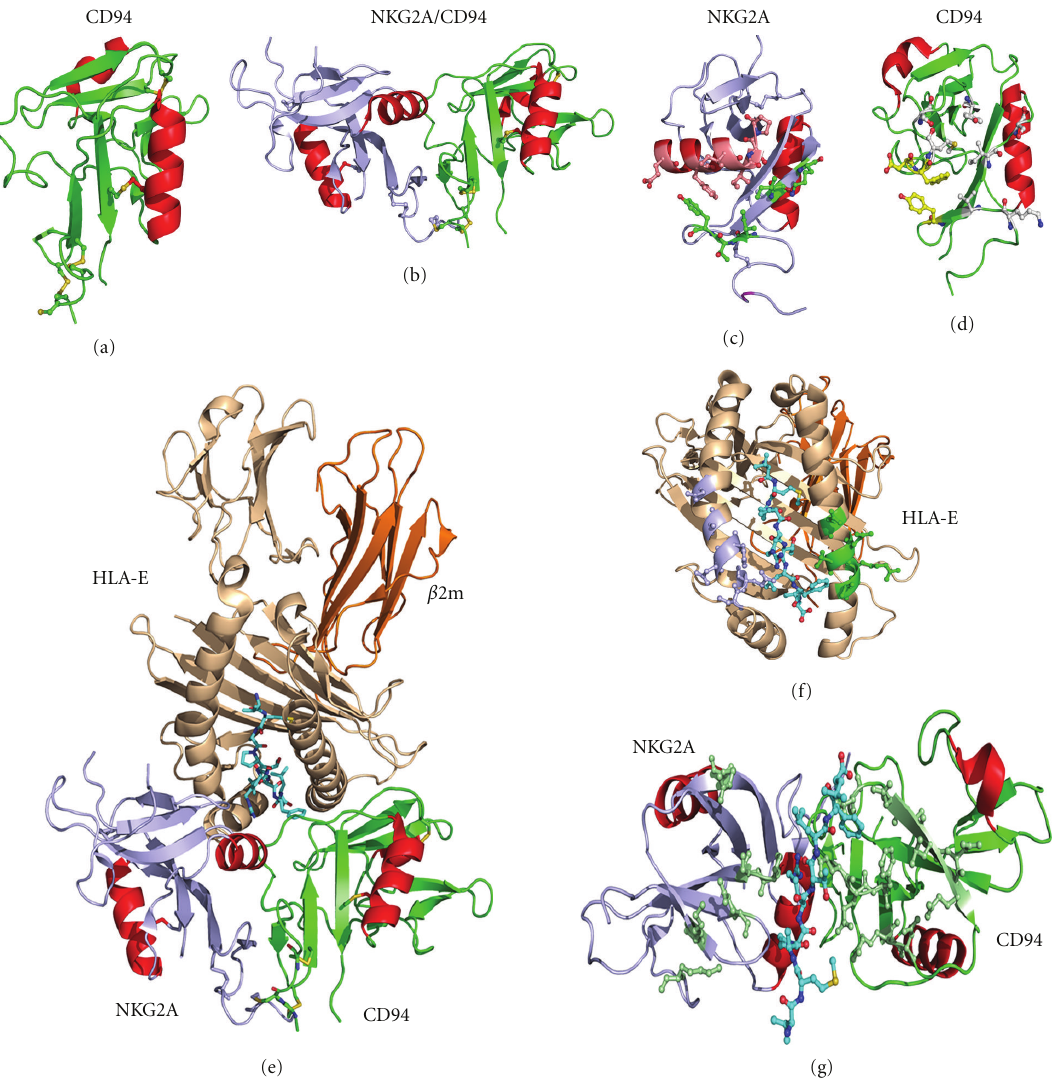
Figure 7: Structure of CD94 and associated complexes. (a) CD94 monomer shown in cartoon representation. (b) NKG2A/CD94 heterodimer structure with NKG2A shown in light blue and CD94 shown in green cartoon representation with each α -helix from both molecules colored red. (c) NKG2A shown in cartoon representation rotated 90 ◦ in relation to (7B) displaying interacting residues in ball and stick representation. Residues colored in green are part of interaction region 1 described in the text while residues colored salmon are part of region 2 also described in the text. (d) CD94 in cartoon representation rotated 90 ◦ in relation to (B) with residues colored yellow part of interaction region 1 while residues colored in grey are part of interaction region 2. (e) Cartoon representation of NKG2A/CD94 in complex with peptide bound HLA-E molecule. The bound peptide is shown in ball and stick representation with o ff -white carbon atoms (f) HLA-E molecule rotated 90 ◦ from (7E) illustrating the HLA-E interaction surface with residues which form bonds with NKG2A and CD94 shown in light blue coloring, and green coloring, respectively. Bound peptide is also shown in ball and stick representation. (g) NKG2A/CD94 molecule rotated 90 ◦ from (7E) showing the HLA-E interaction surface with the bound peptide shown for reference, residues which interact with HLA-E and the peptide are shown colored green in ball and stick